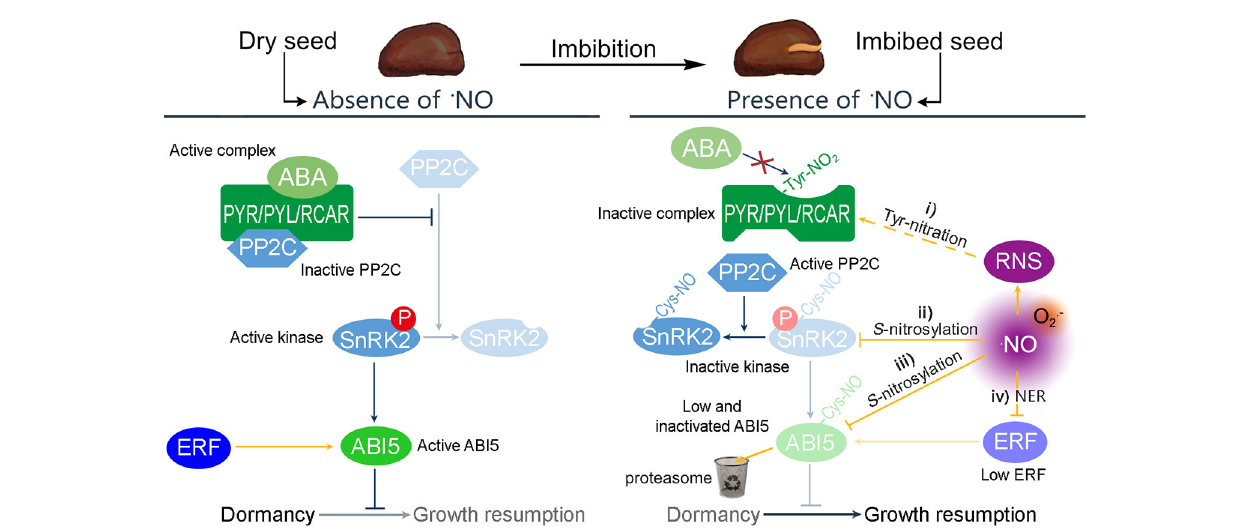
FIGURE 1 | Possible mechanisms by which RNS modulate the ABA regulation of dormancy. In absence of · NO, the transcription factor ABI5 controls the expression of genes relevant to ensure the dormant state. The expression of ABI5 is induced by the Group VII ETHYLENE RESPONSE FACTORS (ERF) and the activity of ABI5 is promoted by SnRK2 kinases. ABA binds to the PYR/PYL/RCAR receptor to complex PP2C and avoid the inactivation of SnRK2. However, seed imbibition produces an increase of · NO levels, resulting in a potential increase of different RNS. In this situation, the ABA control of dormancy can be attenuated by four different pathways: (i) the PYR/PYL/RCAR complex can be S -nitrosylated avoiding the interaction with ABA; (ii) · NO can S -nitrosylate SnRK2 kinases inactivating their kinase activity; (iii) · NO can target ABI5 to the proteasome by S -nitrosylation affecting the expression of genes under its regulation; and (iv) · NO also targets the Group VII ERF to the proteasome, via the N-end rule pathway of